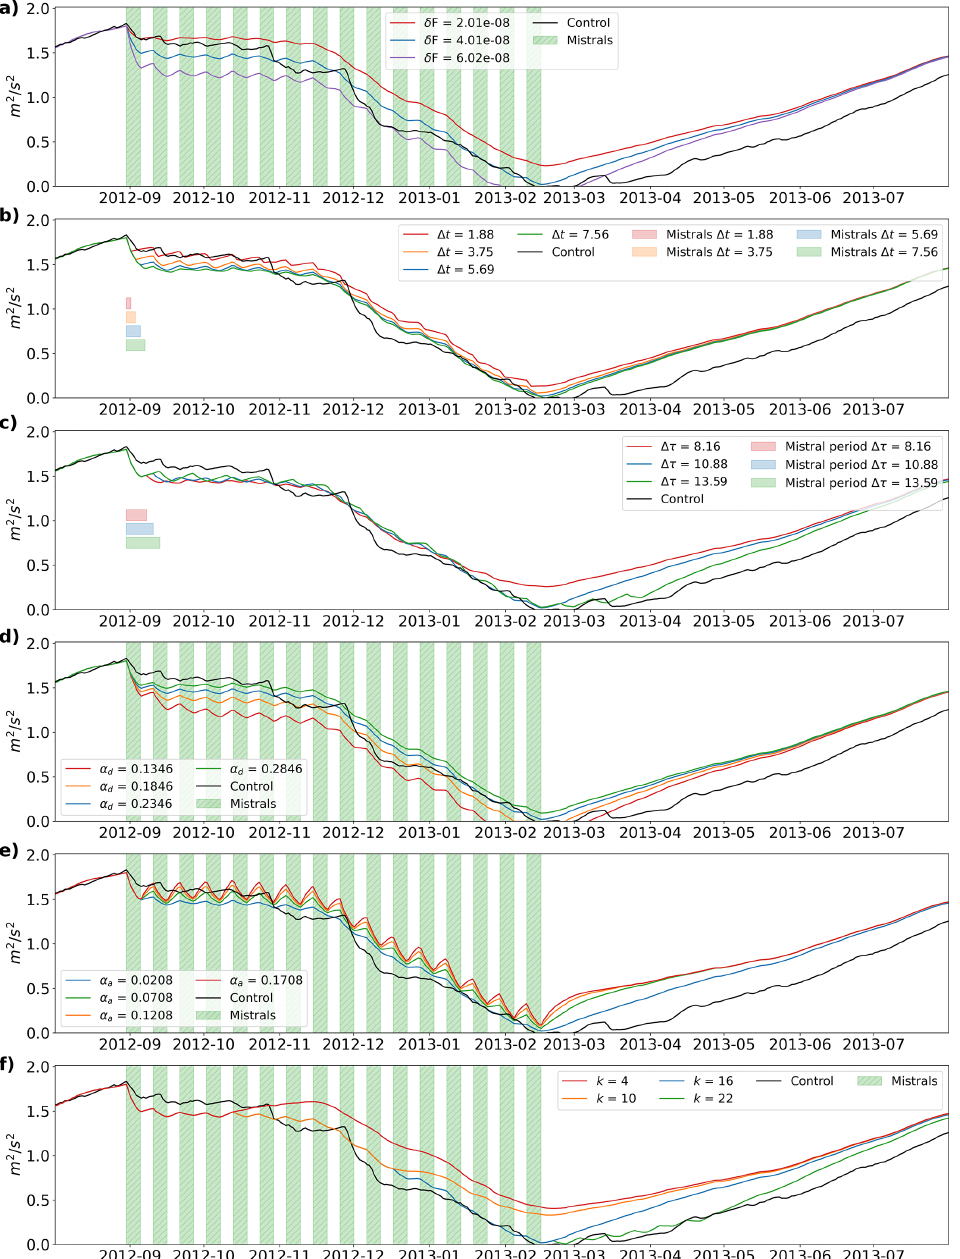
Figure 13. The same as Fig. 12, but SI S is added to the results from Eq.